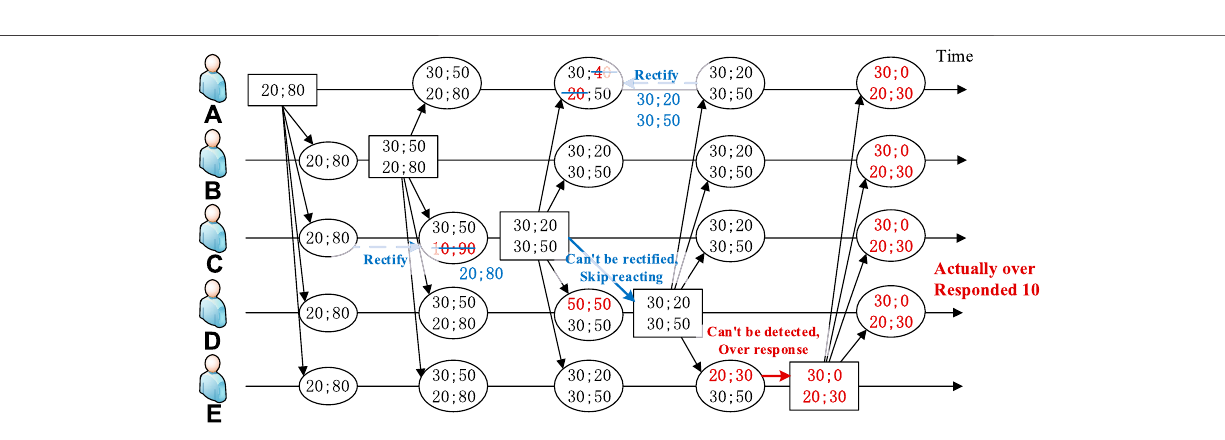
FIGURE 9 | Implementation using the weak-consistency strategy when the information is incorrectly transmitted.